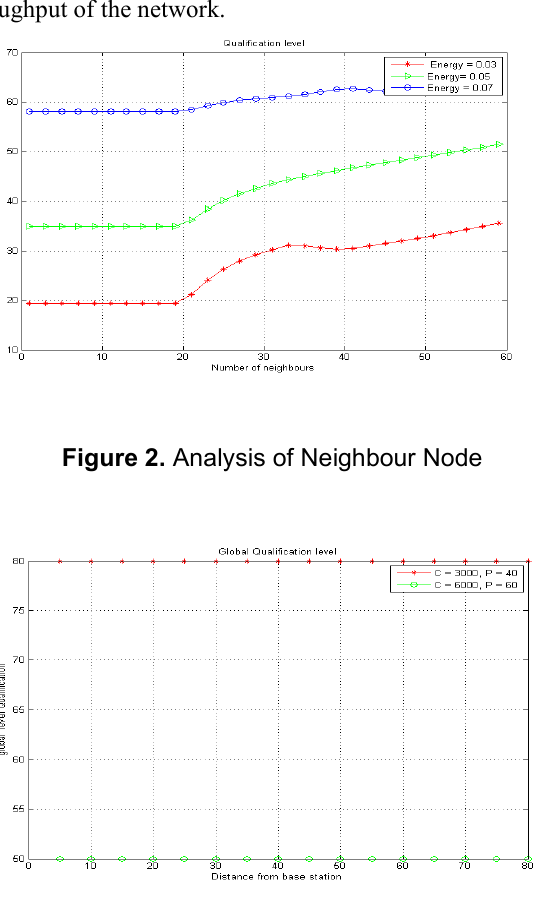
Figure 3. Analysis of Distance of Various Nodes